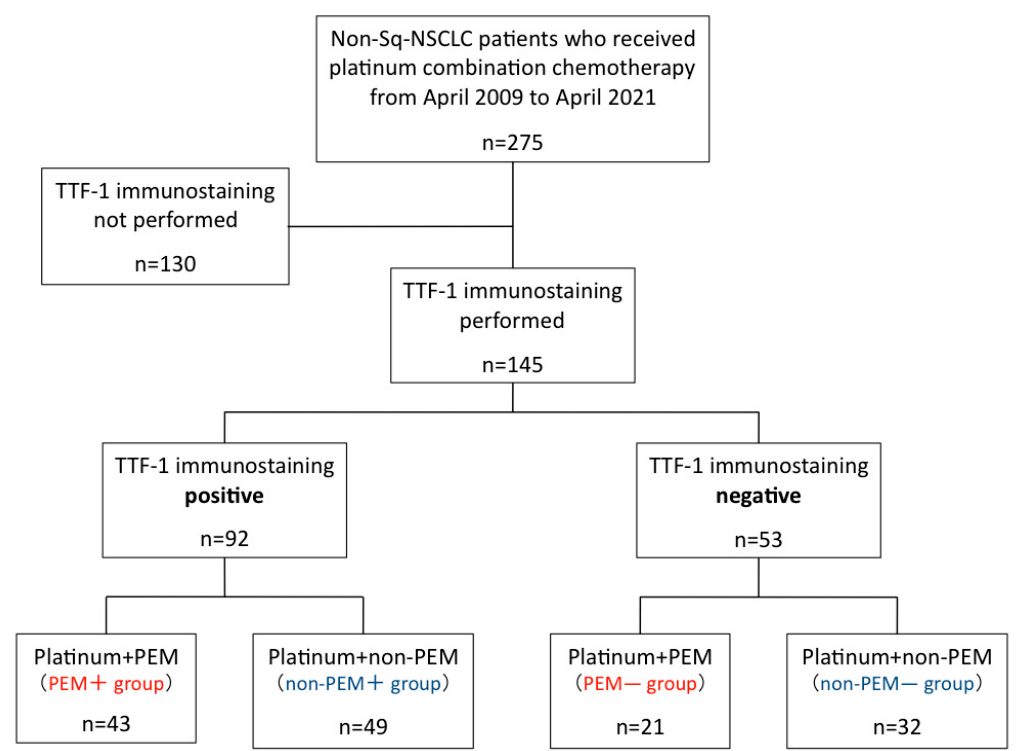
Figure 1. Consort diagram. Abbreviations: sq—squamous cell carcinoma; NSCLC—non-small-cell lung cancer; TTF-1—thyroid transcription factor-1; PEM—pemetrexed.